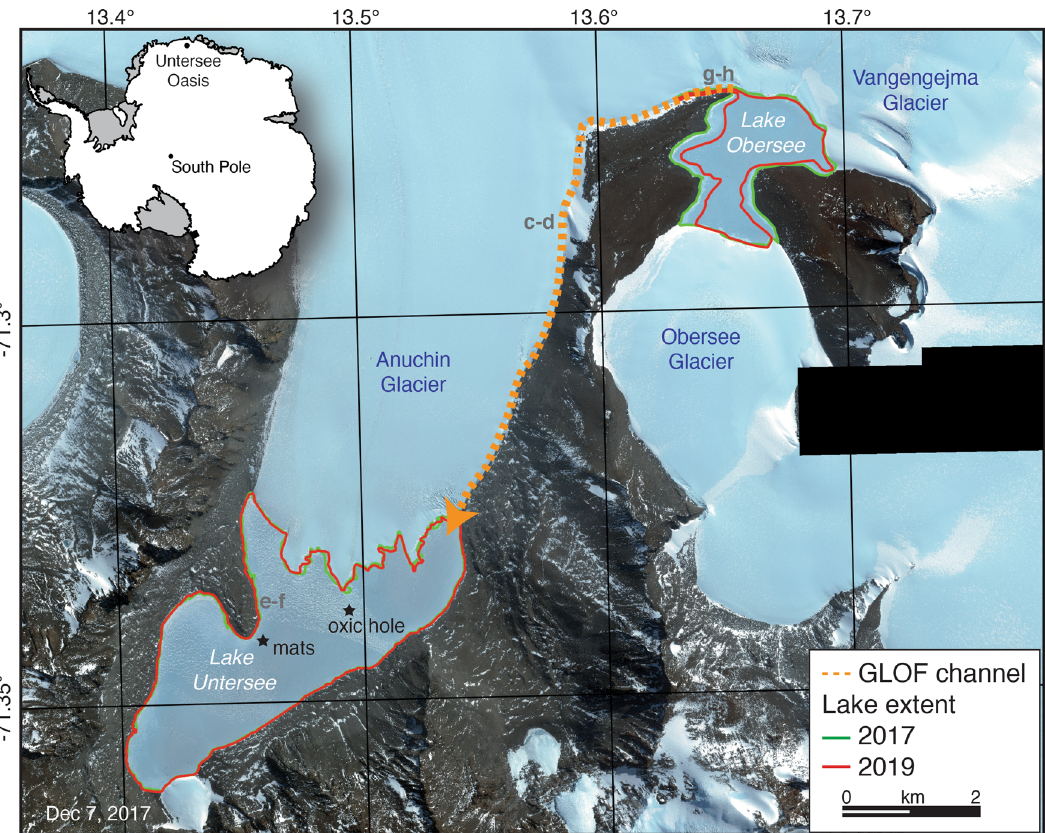
Fig. 1 Lake Untersee Oasis, Dronning Maud Land, Antarctica. Location map showing 2017 – 2019 extents of Lake Untersee and Lake Obersee and fl ow direction of the 2019 glacial lake outburst fl ood. Background Digital Globe NextView satellite imagery, December 7th, 2017; ©2020 Digital Globe NextView License (provided by NGA commercial imagery program). Map generated using QGIS 3.14. Letters indicate the location where photographs shown in Fig. 5 were taken. Stars indicate the sampling location of the benthic mats sampled in study 22 and the oxic water